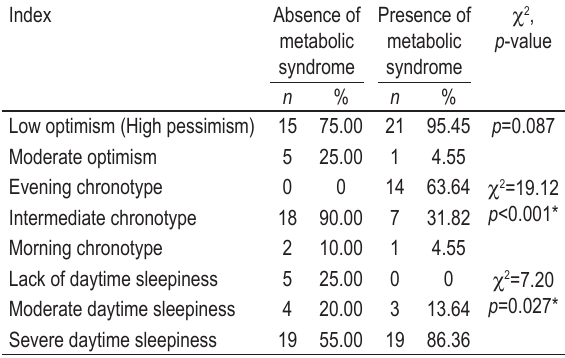
TABLE 5. Frequency of HDL‑C registration according to the criteria of metabolic syndrome in patients with arterial hypertension depending on dispositional optimism, chronotype, and level of daytime sleepiness